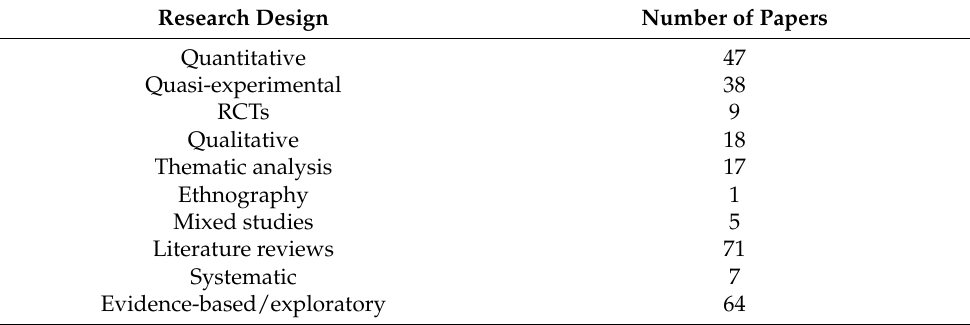
Table 3. Research methods used in corpus